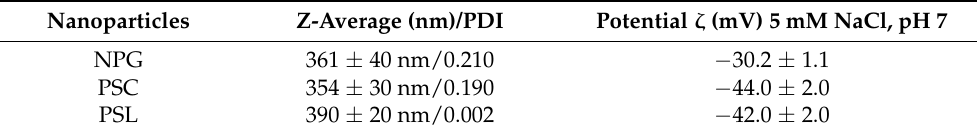
Table 1. Main characteristics of NP dispersions measured by DLS in situ on a Vasco Flex instrument (Cordouan Technologies ® , Pessac,